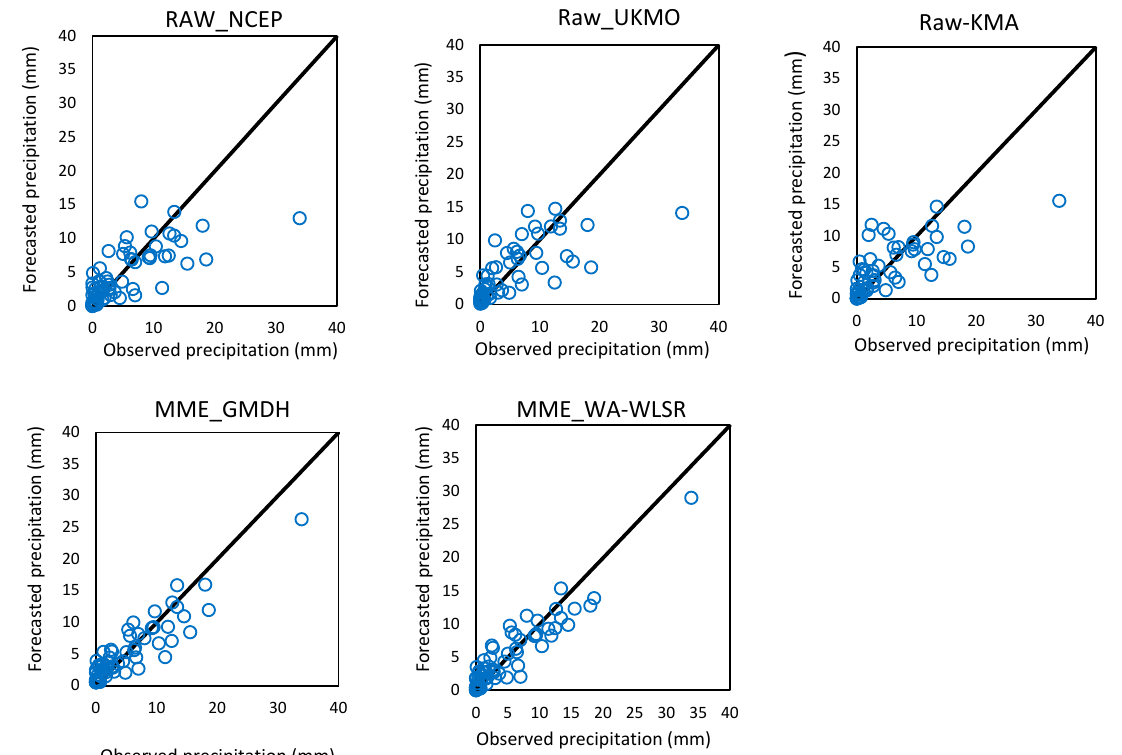
Figure 8. Scatter plots for raw and post-processed ensemble precipitation